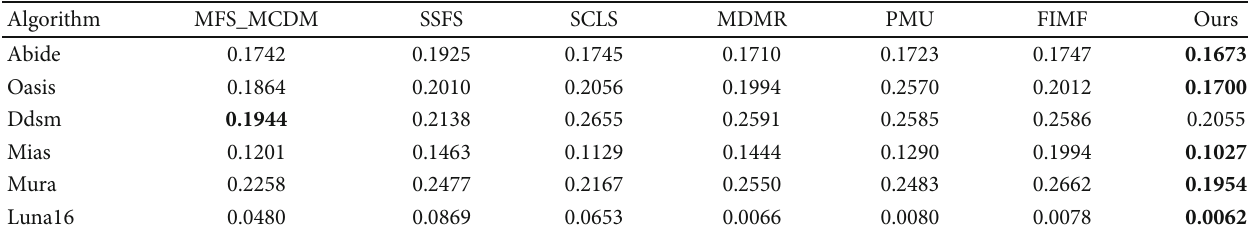
Table 4: Display of optimal experimental results under index ranking loss.